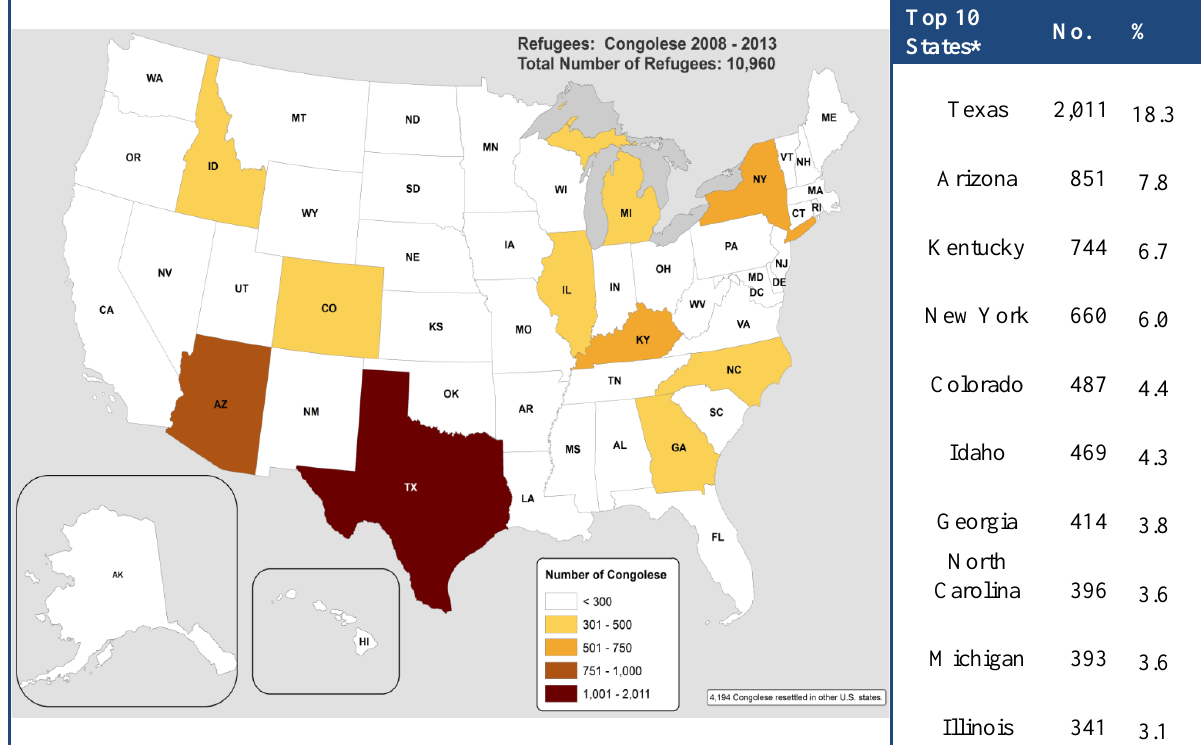
Figure 4: Top 10 US states of primary resettlement for Congolese refugees, 2008 – 2013 (N=10,960)